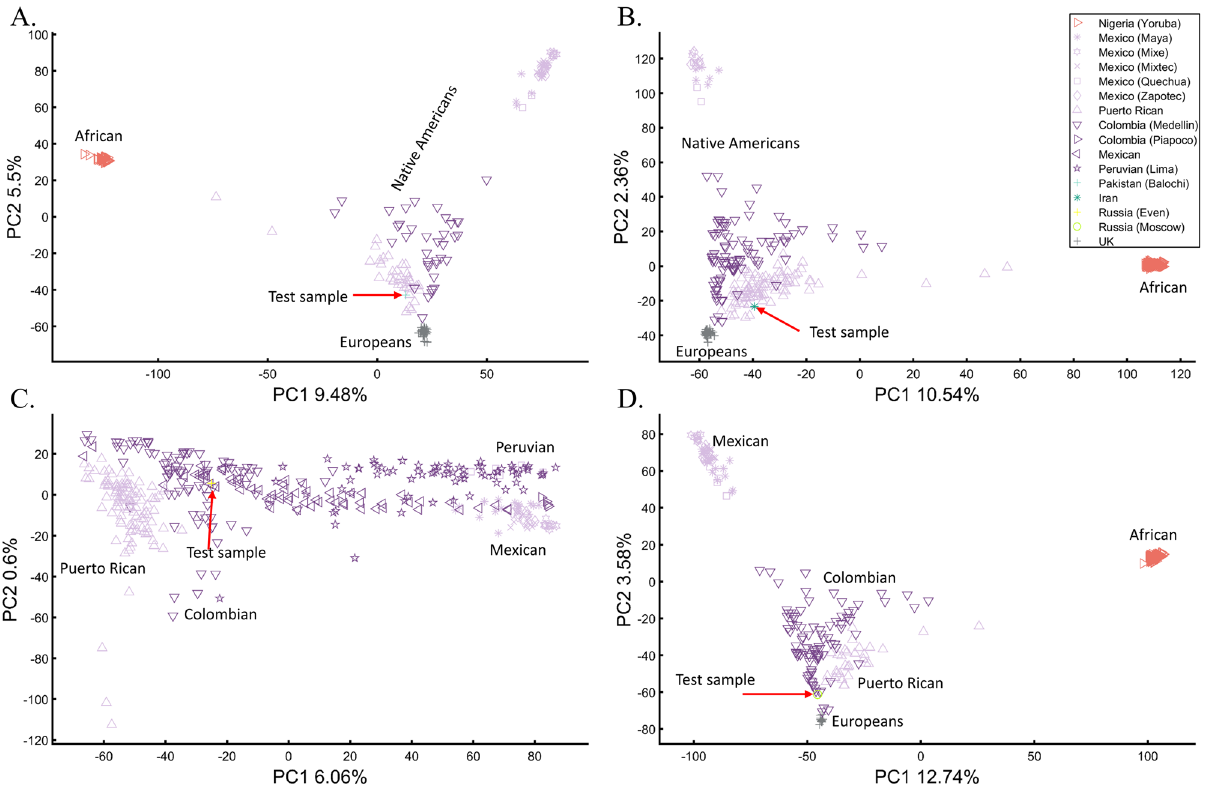
Figure 24. Evaluation of Native American ancestry for four Eurasians. ( A ) Using even-sample size ( n = 37) for Africans, Mexican-Americans, British, Puerto Ricans, Colombians, and a Pakistani. ( B ) Using uneven-sample sizes, for Africans ( n = 100), Mexican-Americans ( n = 20), British ( n = 50), Puerto Ricans ( n = 89), Colombians ( n = 89), and an Iranian. ( C ) Analyzing a whole-Amerindian cohort of Colombian ( n = 93), Mexican-Americans ( n = 117), Peruvian ( n = 75), Puerto Ricans ( n = 102), and an Even Russian. ( D ) Using uneven-sample sizes, for Africans ( n = 100), Mexican-Americans ( n = 53), British ( n = 20), Puerto Ricans ( n = 30), Colombians ( n = 89), and a Moscow Russian. All the samples were randomly